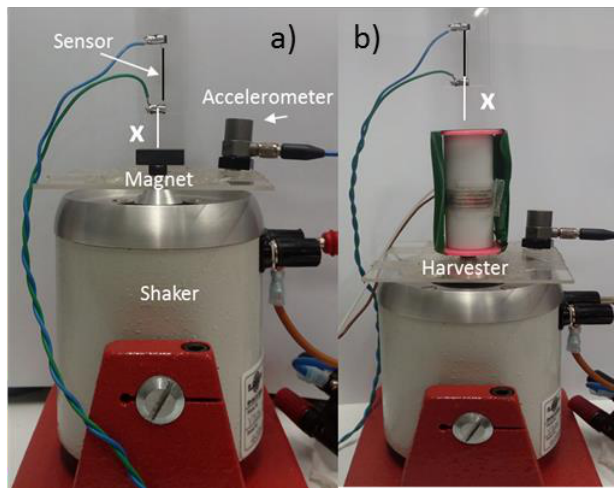
Figure 4. Experimental setup employed in the vibrating system (shaker): the accelerometer and the GMI sensor, ( a ) the ferrite magnet; ( b ) the harvester.